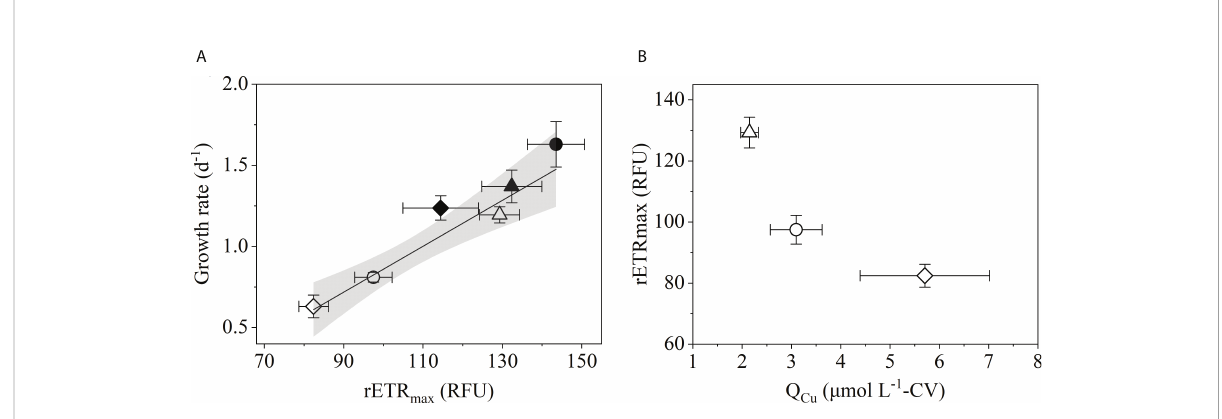
FIGURE 4 (A) Speci fi c growth rate as a function of maximum relative electron transport rate (rETR max ) of LCuA 1nM ( ◮ ), CCuA ( ◑ ) and ancestral ( ⬗ ) populations grown in Cu-de fi cient (open symbols) and Cu-suf fi cient ( fi lled symbols) medium. The solid line through the data points is the least squares linear regression (F (1,4) = 47.1, p=0.002) with the grey band indicating the 95% con fi dence interval. (B) rETR max as a function of Cu quota (Q Cu ) of LCuA 1nM ( △ ), CCuA ( ○ ) and ancestral ( ♢ ) T. oceanica populations grown in Cu-de fi cient medium. Error bars represent ± 1 SD of three (rETR max and Q Cu ) or ten to fi fteen (growth rate) biological